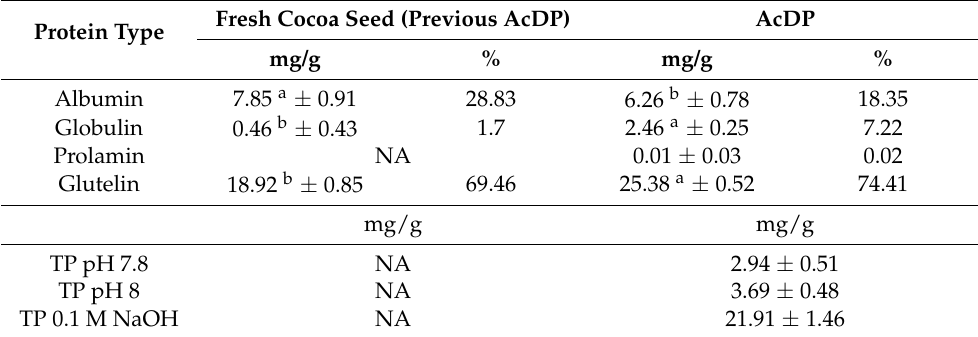
Table 1. Concentration and percentage of T. cocoa proteins obtained without and with AcDP.